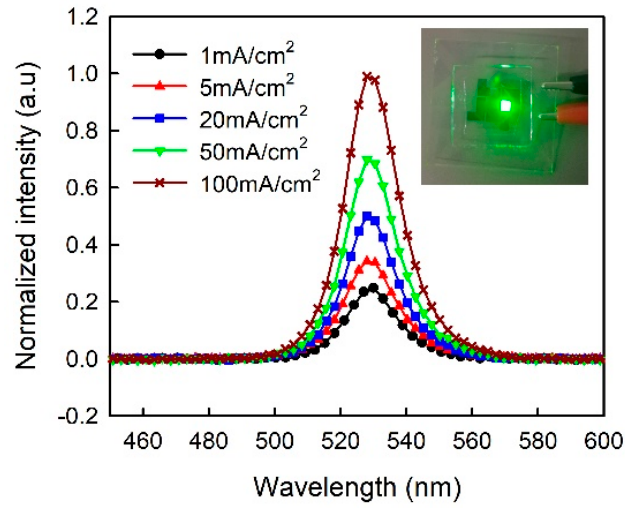
Figure 7. EL spectra of the PeLED devices with a three-step spin-coated emitter and a PEDOT:PSS/MoO 3 -ammonia (1:0.02) composite HTL at different current densities. The inset is a luminescence image of the device at 50 mA/cm 2